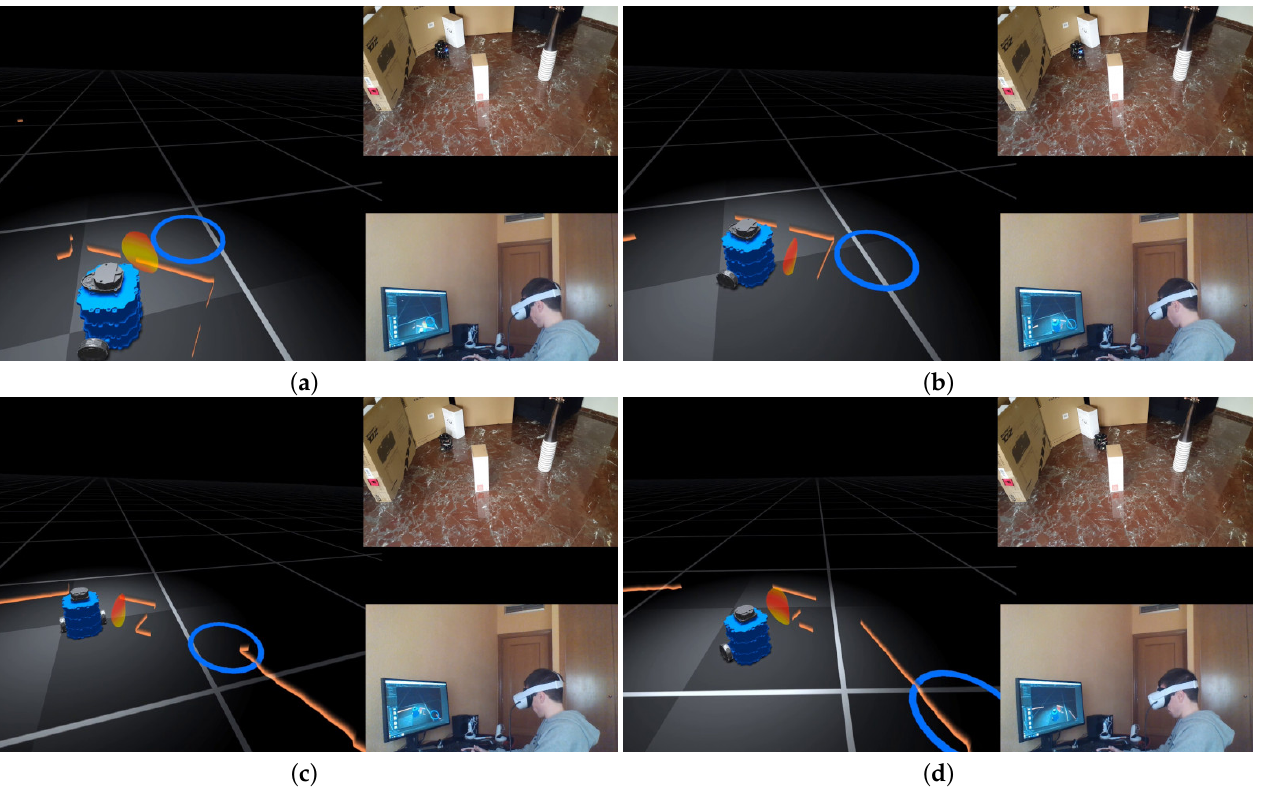
Figure 8. Case study 2: frames of the video showing a trap situation. ( a ) video: 2 min 20 s. ( b ) video: 2 min 32 s. ( c ) video: 2 min 42 s. ( d ) video: 2 min 55